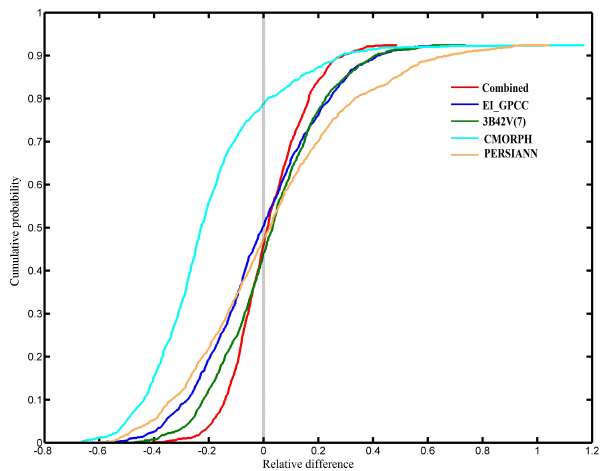
Figure 6. Cumulative probability for the precipitation forcing